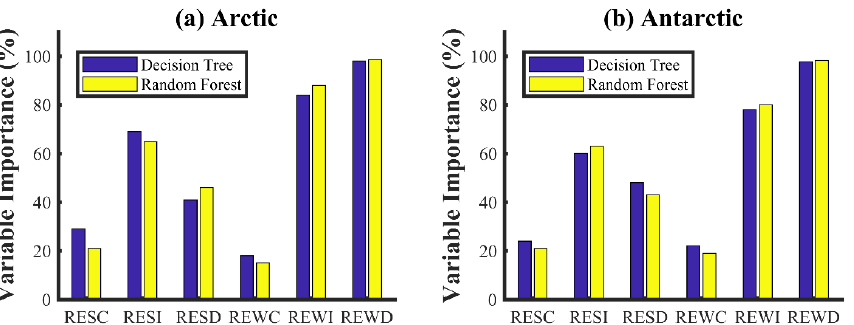
Figure 9. Relative importance of variables to sea ice monitoring using decision tree (DT) and random forest (RF) algorithms over the ( a ) Arctic and ( b ) Antarctic regions.